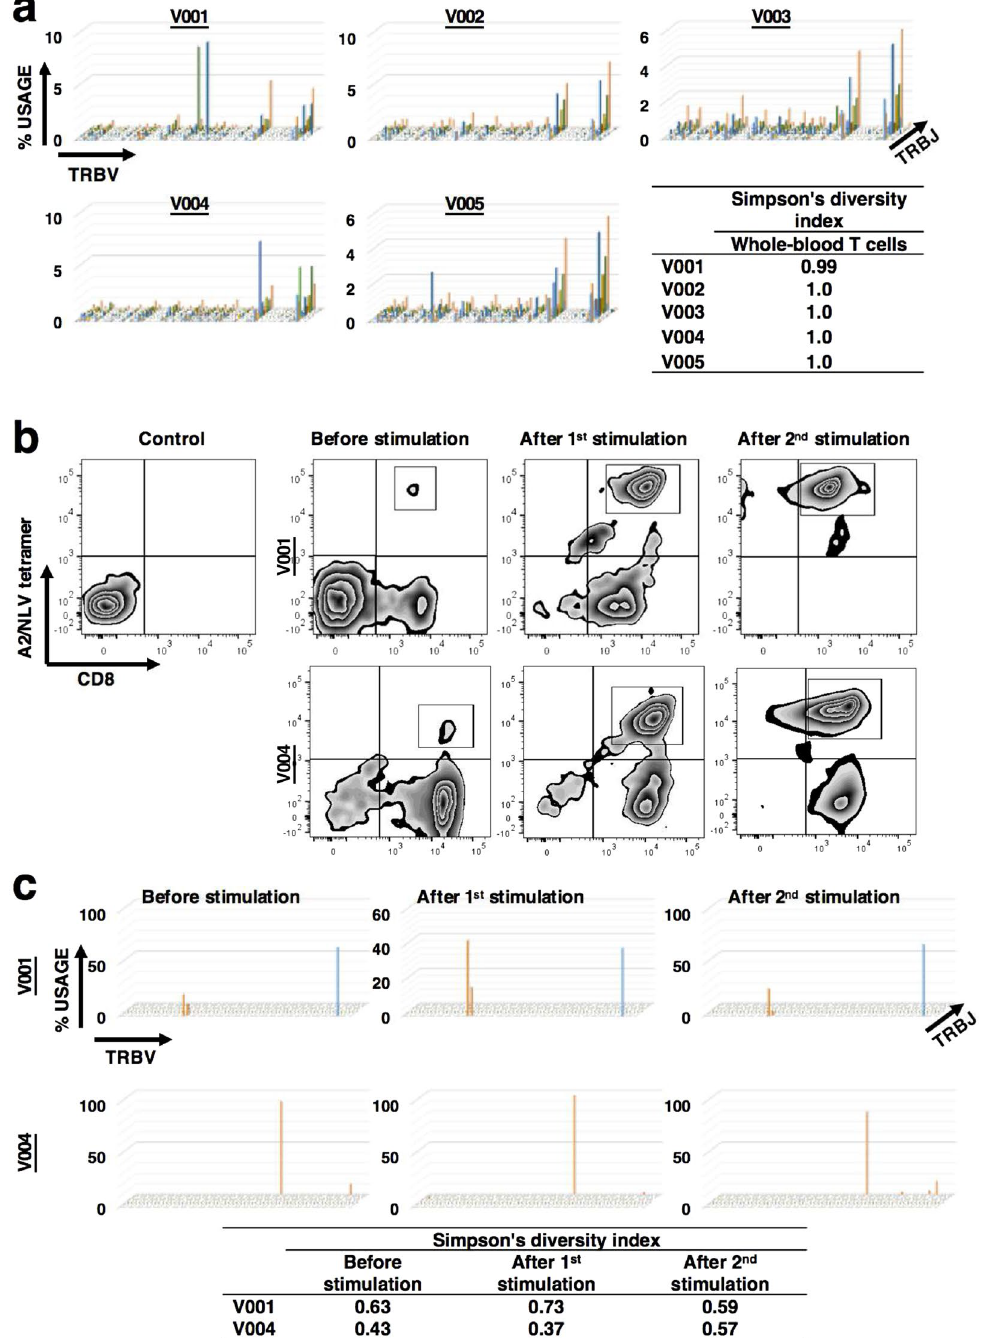
Figure 1. Diversities of the entire T cell repertoires and CMV NLV-specific T cell repertoires among five healthy donors. ( a ) NGS of the T-cell repertoire identifies specific CDR3 amino acid sequences and expression of TCR β variable ( TRBV )- and joining ( TRBJ )-region genes. Diversity Index and TCR repertoire plots illustrate the wide range of diversity of the total T cell populations of five healthy donors (V001, V002, V003, V004 and V005). ( b ) Representative flow cytometric profiles of unstimulated and stimulated PBMCs derived from V001 (HLA-A2-positive and CMV-seropositive healthy donor) for HLA-A2-NLV tetramer-positive cells. PBMCs were stimulated once or twice with autologous antigen-presenting cells pulsed with the peptide NLVPMVATV (NLV) in vitro . The stimulation protocol is detailed in the Methods section. ( c ) T-cell repertoire plots and Diversity Index of CMV NLV-specific CD8 + T cells sorted from unstimulated and stimulated PBMCs from two healthy donors (V001 and V004; HLA-A2-positive and CMV-seropositive healthy donors, respectively). CMV NLV-specific CD8 + T cell repertories are oligoclonal before and after antigen